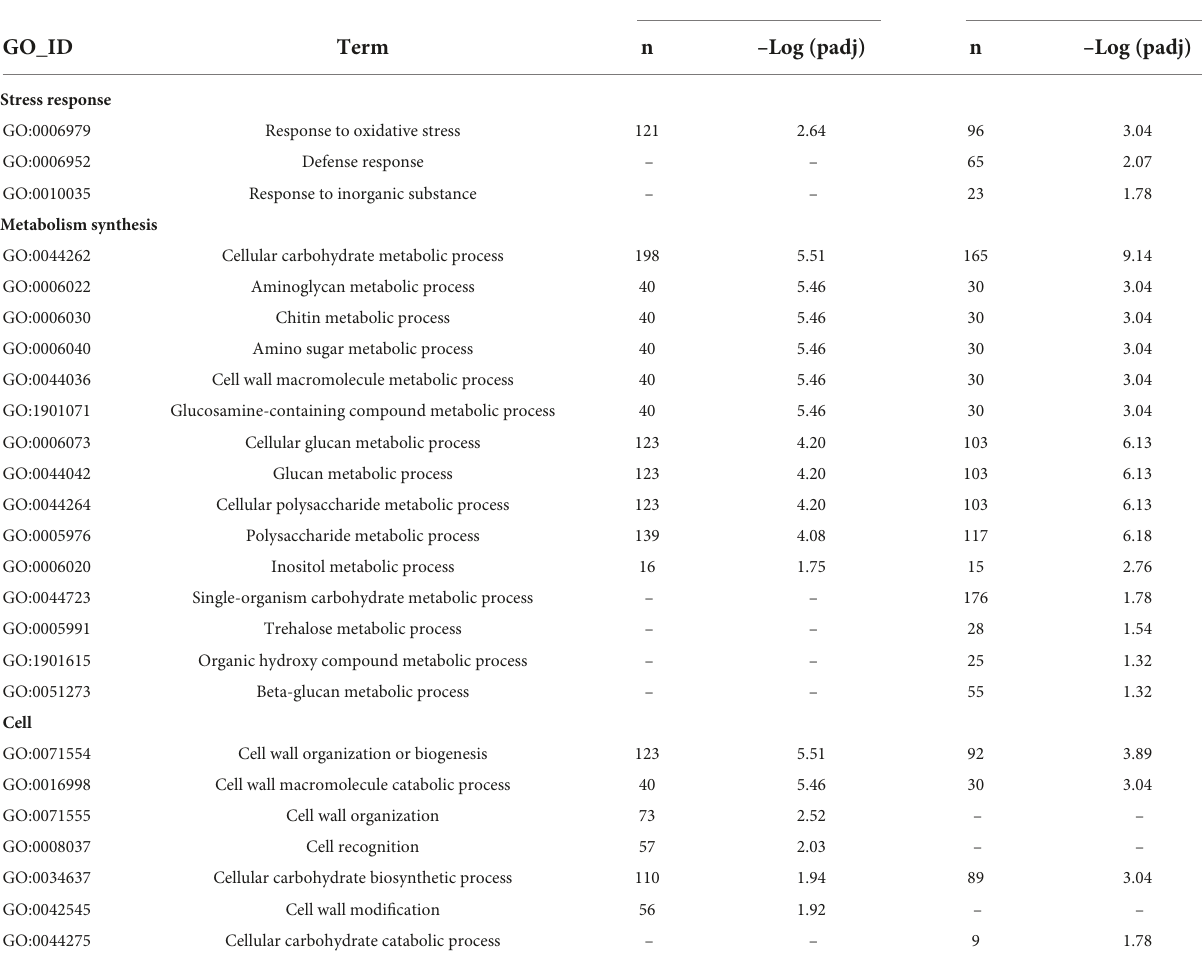
TABLE 1 Comparison of GO-terms (biological processes) enriched in ZS9m Xcc R-1 and ZS9m Xcc S-1 upon Xcc